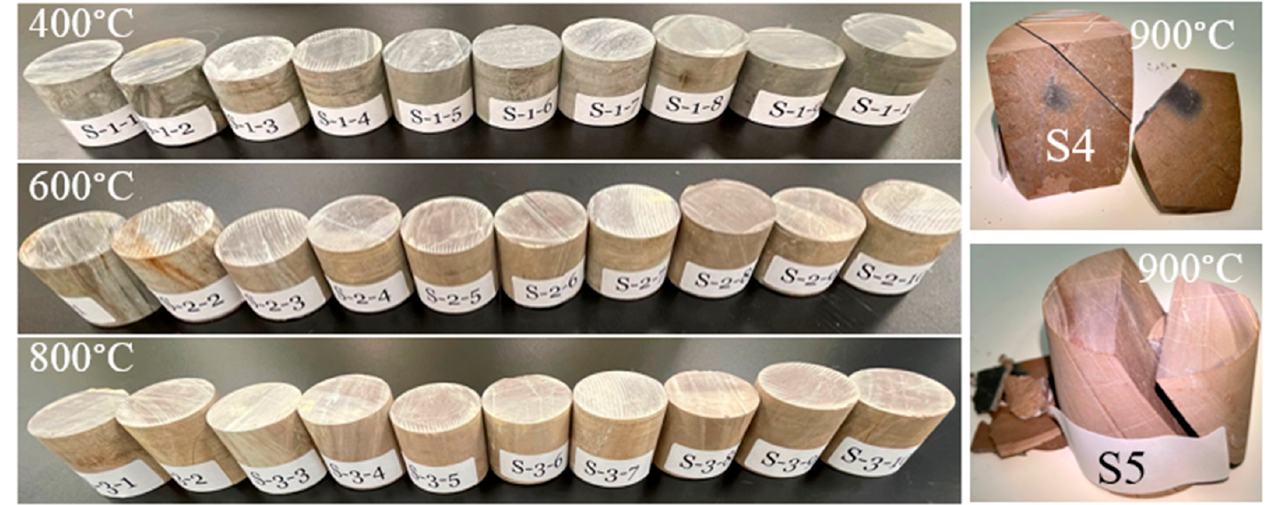
Figure 4. Samples after heating experiments (from room temperature to 400, 600, 800 and 900 °C).